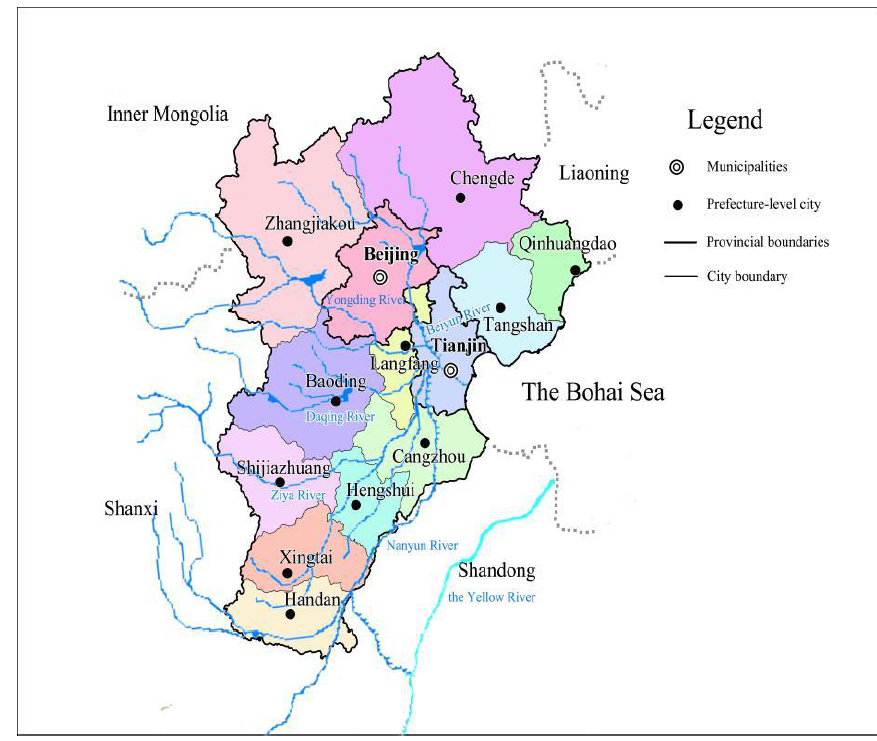
Figure 1. Sketch map of Beijing – Tianjin – Hebei (BTH) urban agglomeration.